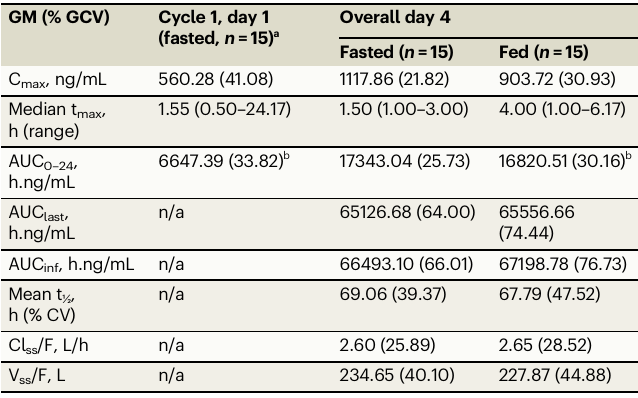
Table 3 | Effects of food on trotabresib pharmacokinetics in patients with advanced solid tumors in part